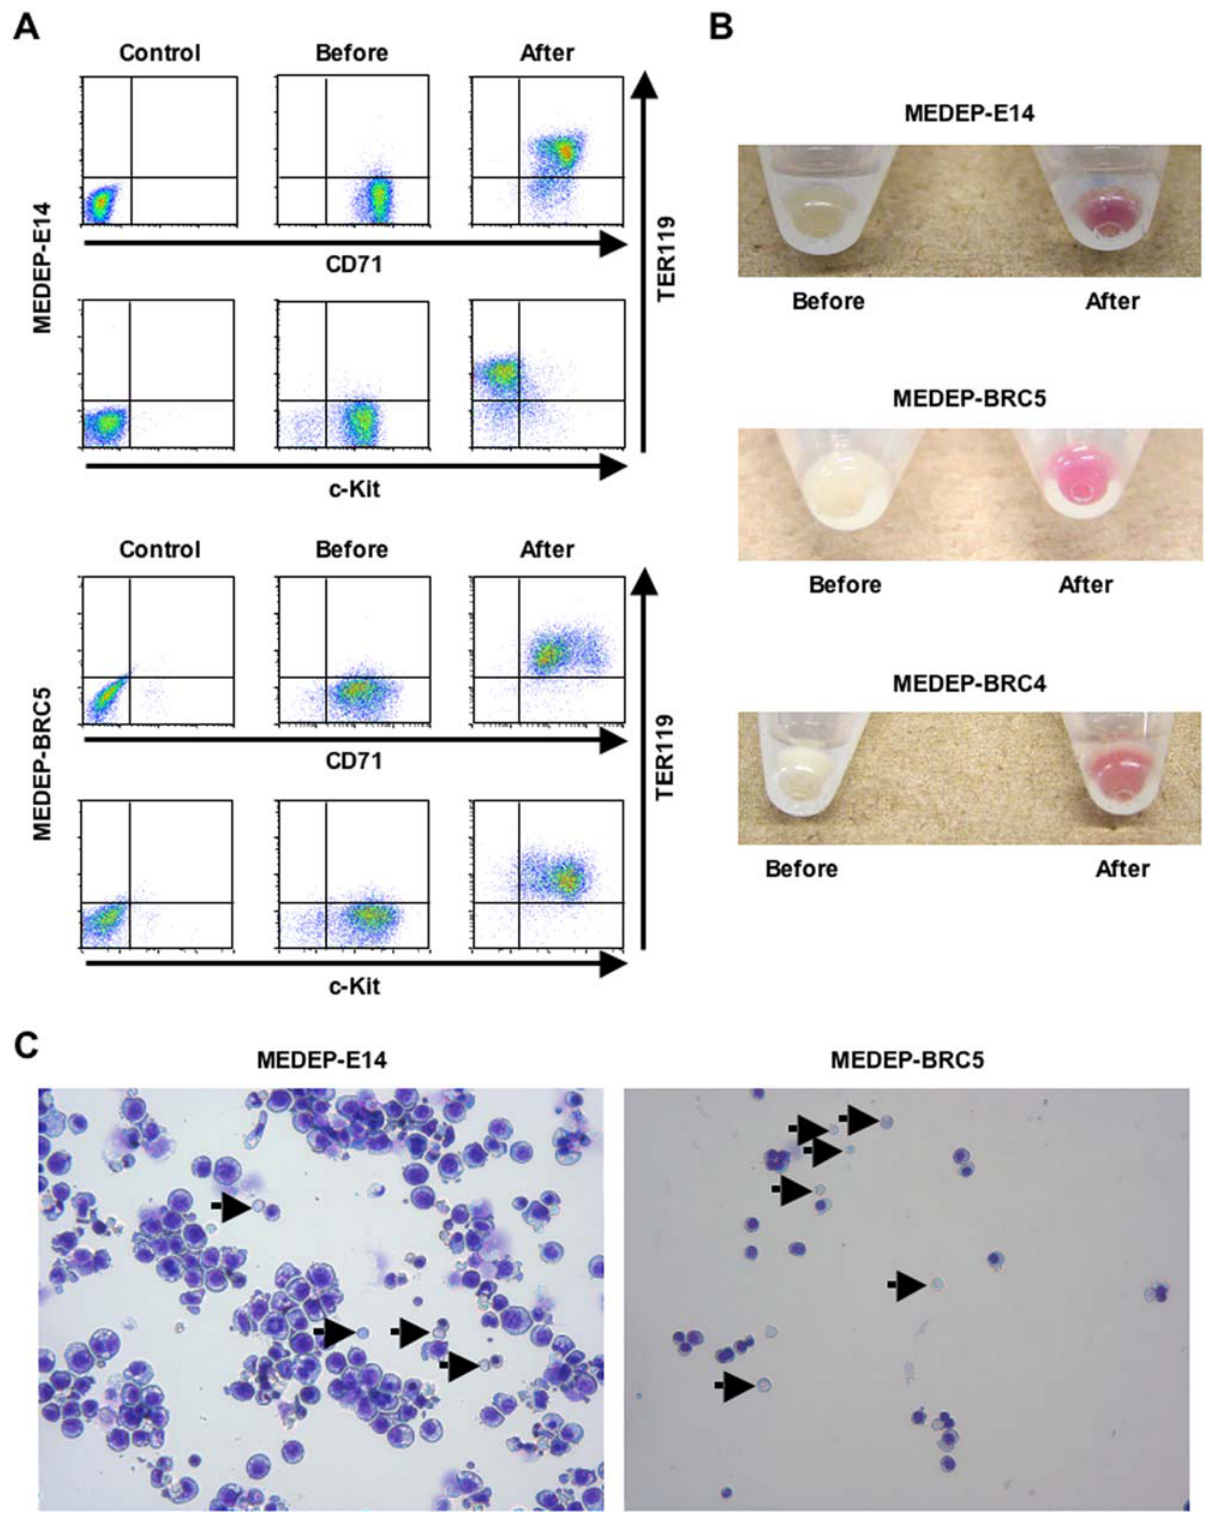
Figure 2. In vitro differentiation of MEDEP. The in vitro differentiation of MEDEP-E14 was performed by culture for two days after deprivation of erythropoietin (EPO). The in vitro differentiation of MEDEP-BRC5 was performed by culture for three days after deprivation of stem cell factor (SCF) and addition of EPO. (A) Flow cytometric analyses. Control, results with isotype controls. Before and After, the cells before and after in vitro differentiation. CD71, transferrin receptor. c-Kit, receptor for SCF. TER119, a cell surface antigen specific for mature erythroid cells. (B) Cell pellets before and after in vitro differentiation. The method for in vitro differentiation of MEDEP-BRC4 is described in Figure S4. (C) Morphology of the cells after in vitro differentiation. Arrows indicate enucleated red blood cells. (A–C) Results shown are representative of three independent experiments.